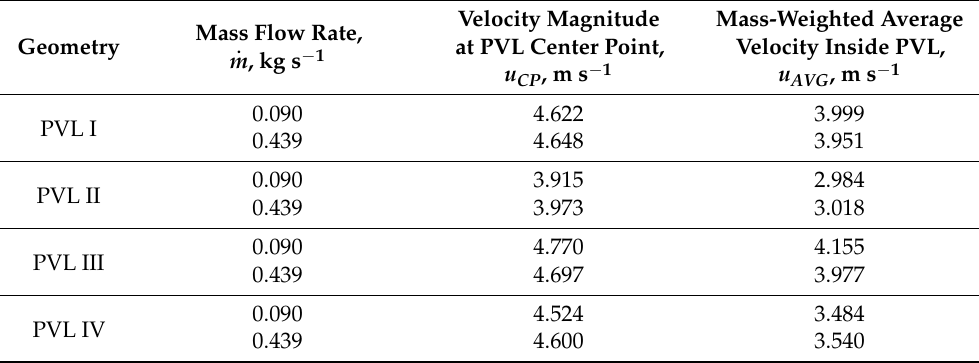
Table 2. Characteristic velocity magnitude values inside PVLs.